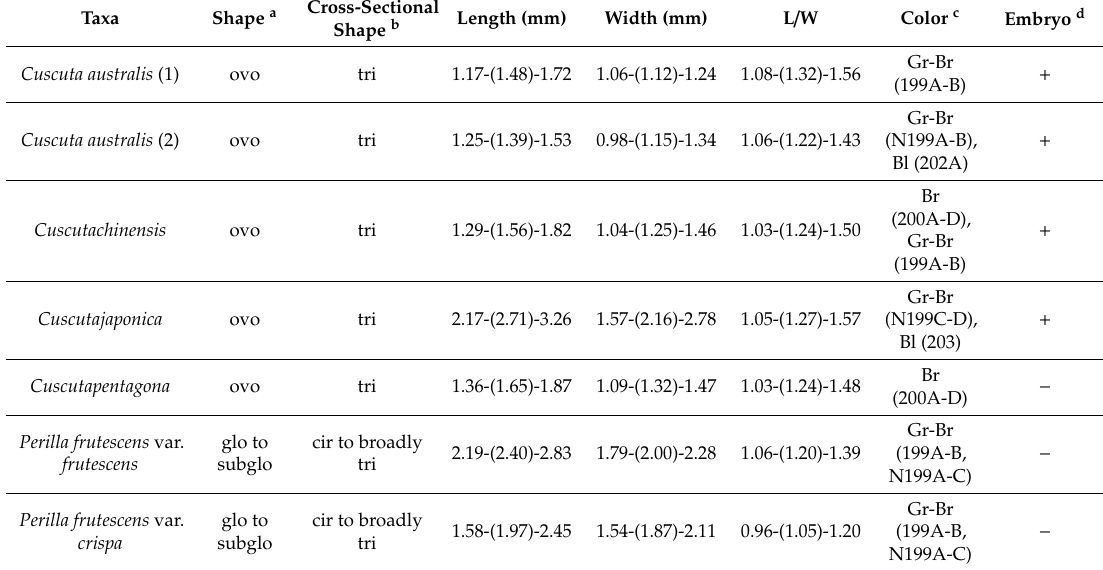
Figure 1. Stereomicrographs showing seed morphology and embryo exudation. ( A ) Cuscuta australis . ( B ) C. chinensis . ( C ) C. japonica . ( D ) C. pentagona . ( E ) Perilla frutescens var. frutescens . ( F ) P. frutescens var. crispa . Scale bars = 1 mm. Table 1. Seed morphological characteristics of original species of Cuscutae Semen, congeneric, and adulterant